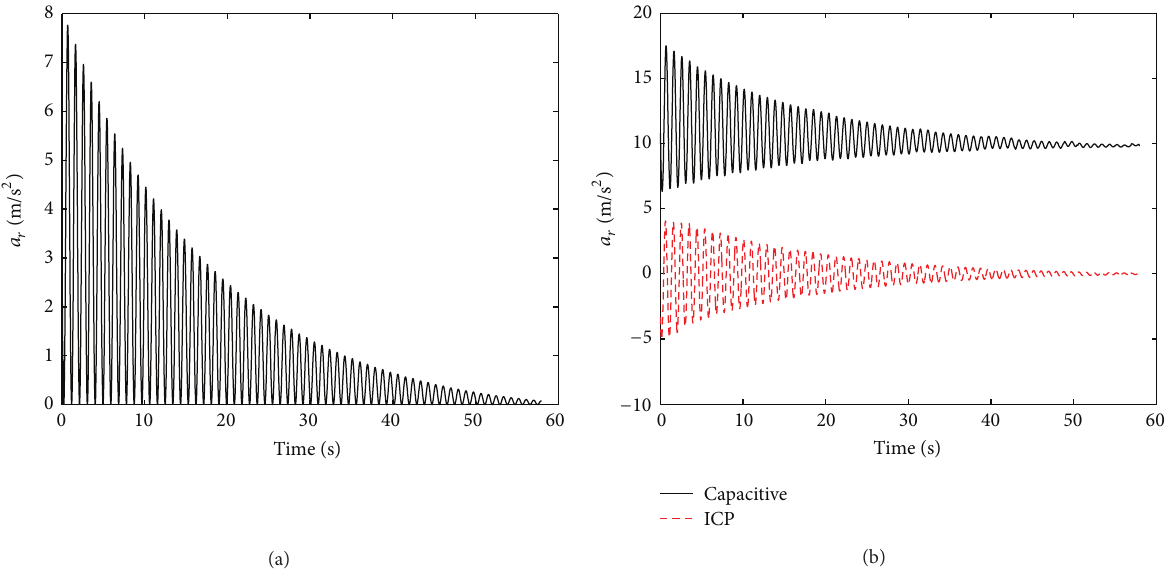
Figure 2: (a) Actual value of the radial acceleration. (b) Measured radial accelerations, by the capacitive and the ICP sensor.